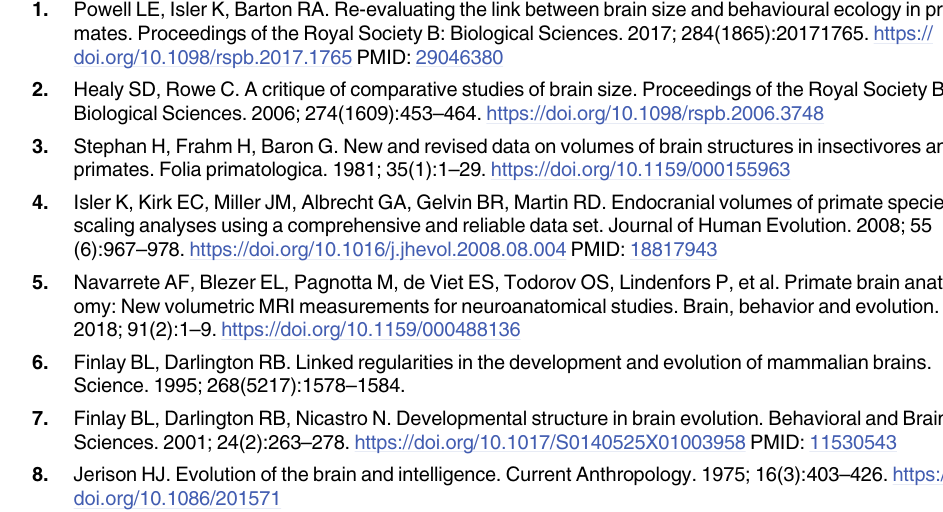
S7 Table. Data used to reevaluate DeCasien et al. [35]. S8 Table. Reevaluating Joffe [40] results of a significant relationships between juvenile period and the ratio of non-visual cortex to the rest of the brain.